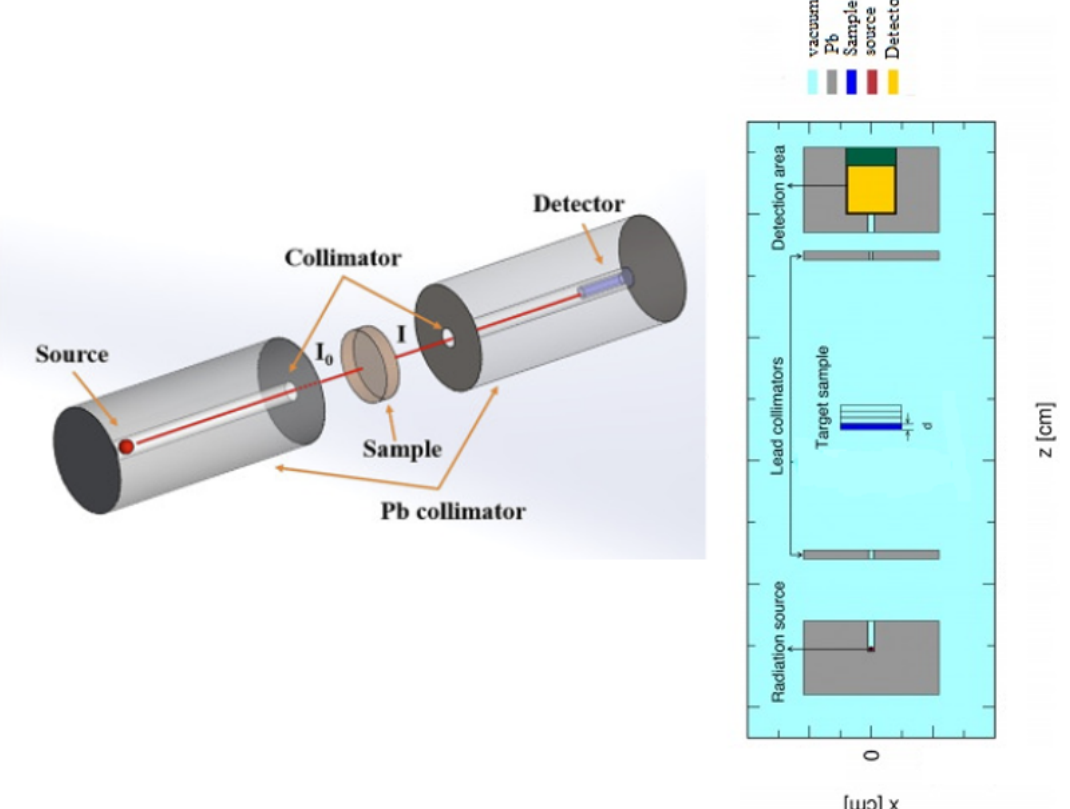
Figure 2. Simulation FLUKA setup for incident gamma radiation with glass samples.